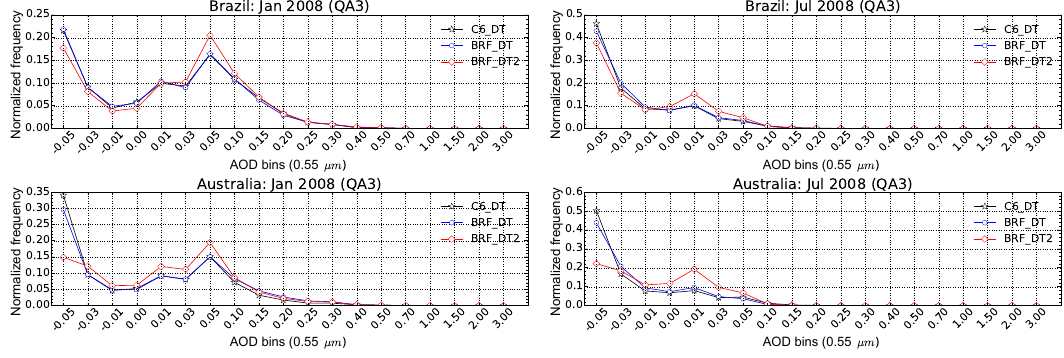
Figure 11. Histograms for the AOD (at 0.55µm) in Brazil and Australia. The AOD data are from the global land area. Other symbols are similar to Fig. 9.